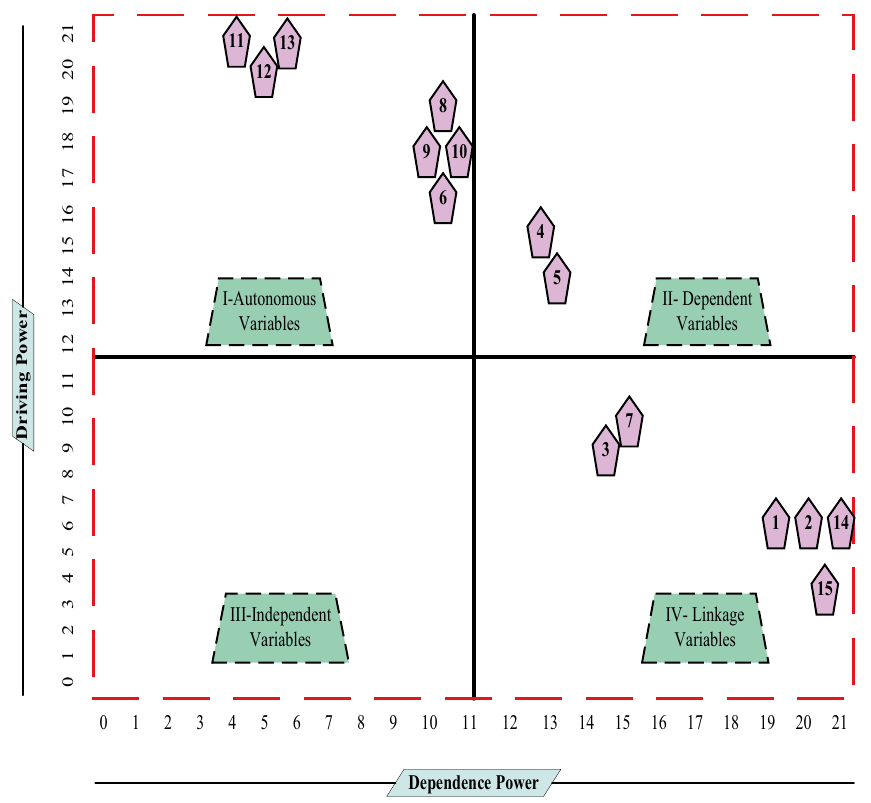
Figure 2. Factors of driving and dependence powers.